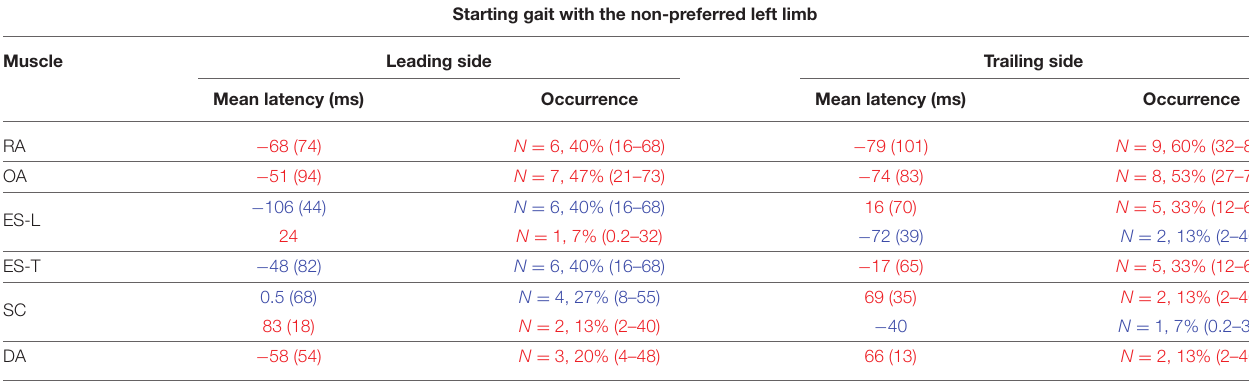
TABLE 2 | Mean latency of APAs with SD (in parentheses) for each postural muscle when starting gait with the non-preferred limb. Starting gait with the non-preferred left